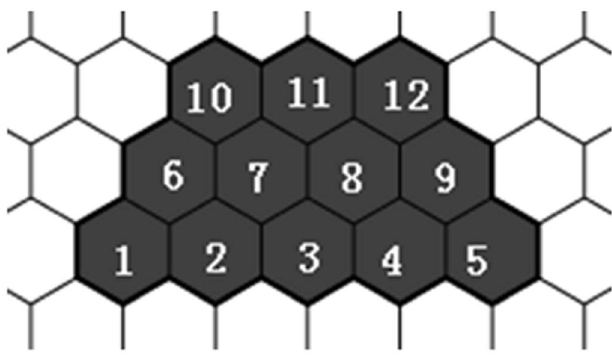
Figure 4. An isosceles trapezoid on a hexagonal lattice.